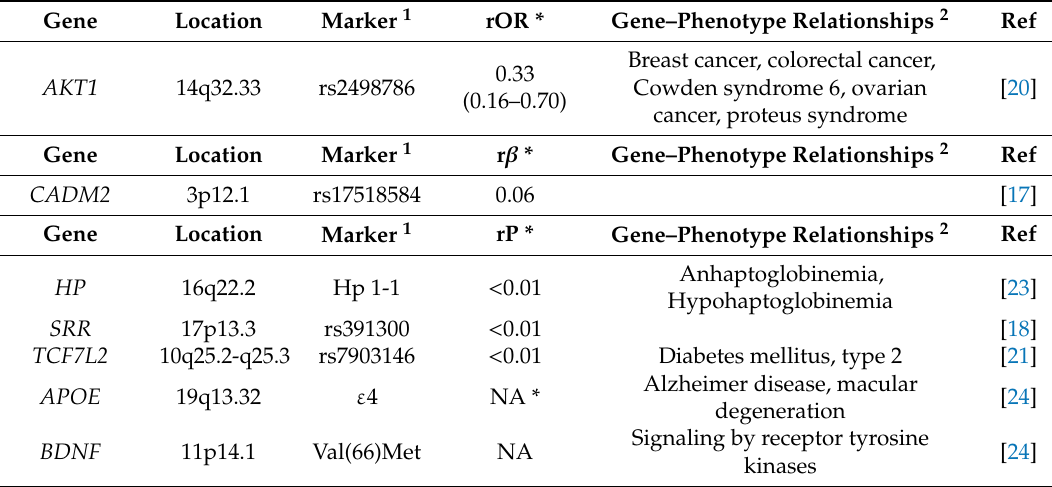
Table 1. Genes Associated with both Diabetes Mellitus and Dementia.